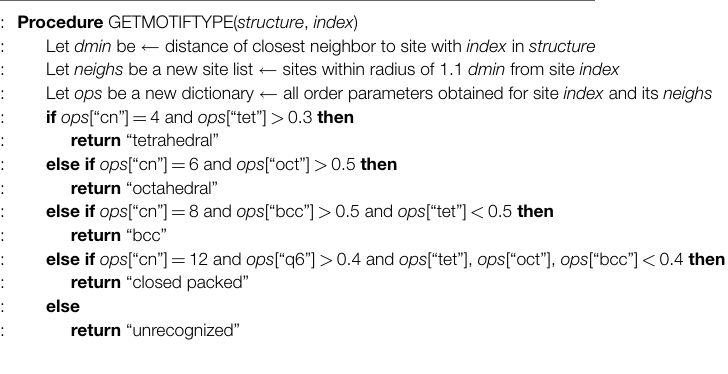
ALGORITHM 1 | Motif